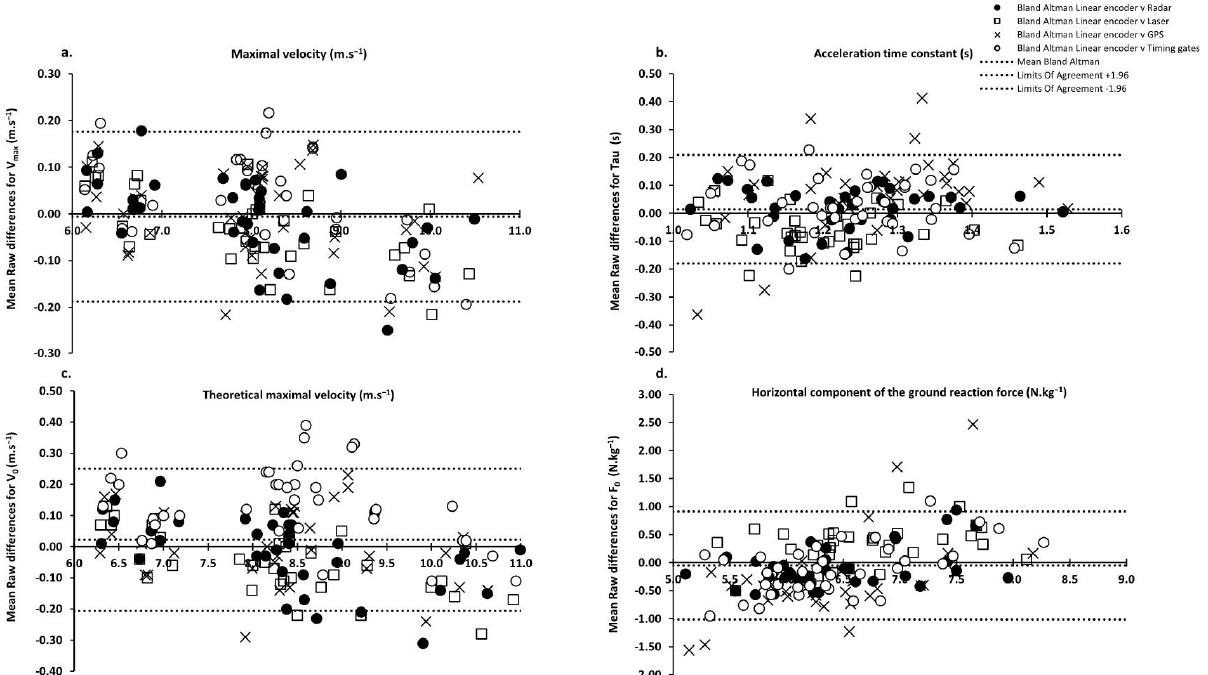
Figure 2. Bland and Altman comparisons between the linear encoder and other systems [24]. Mean raw differences with the linear encoder were computed for ( a ) maximal velocity (V max ), ( b ) acceler ‐ ation time constant (Tau), ( c ) theoretical maximal velocity (V 0 ), and ( d ) horizontal component of the ground reaction force (F 0 ).